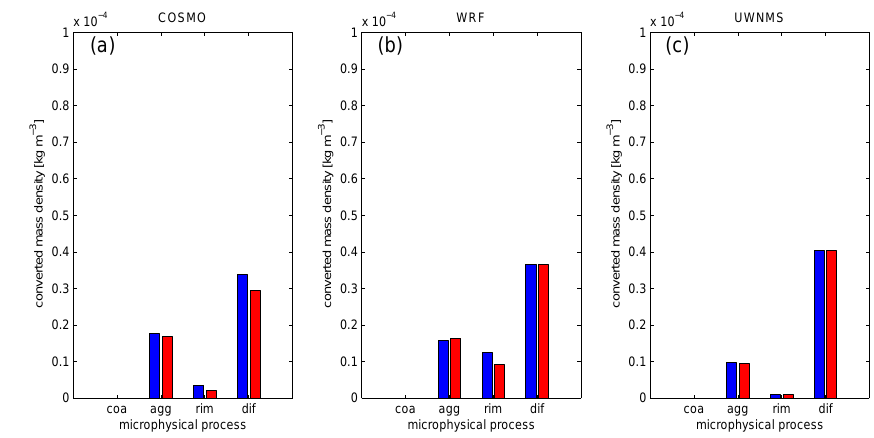
Fig. 20. Same as Fig. 10 but for the simulations SIM 4 CC (blue) and SIM 4 PC (red).